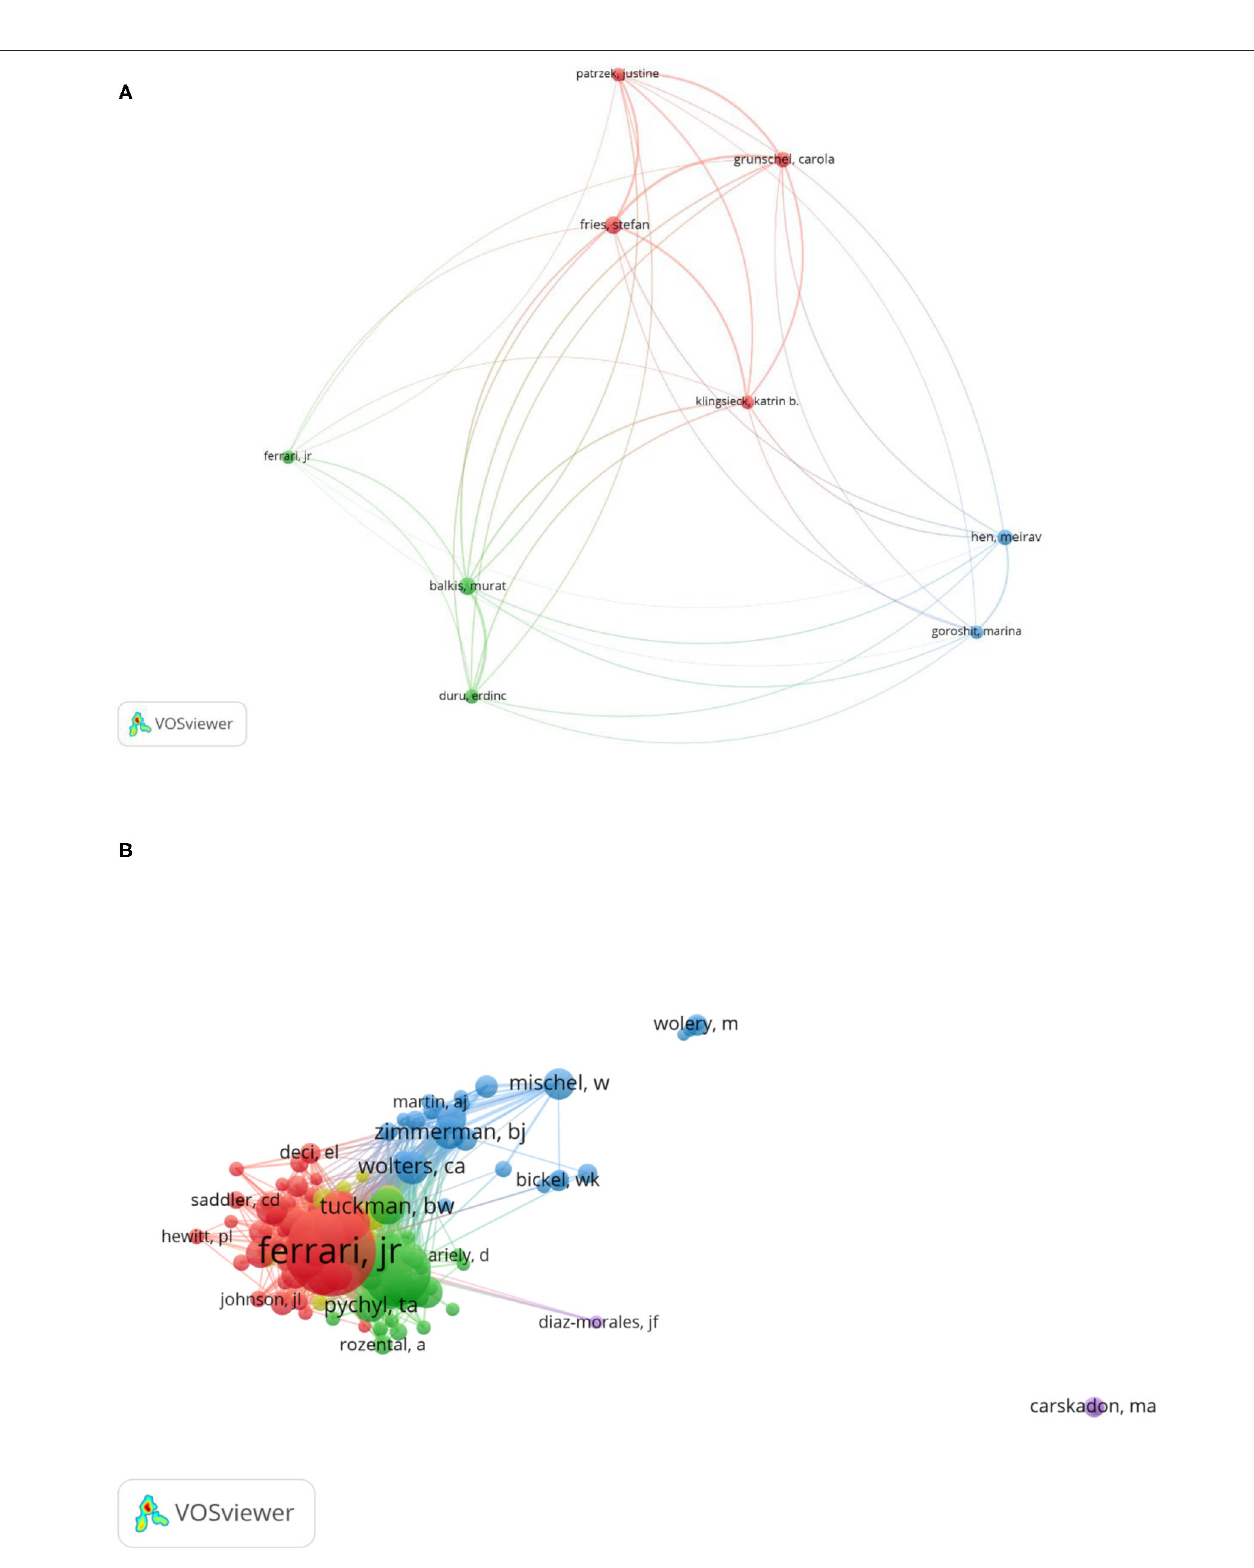
FIGURE 4 | The visualization map of main authors participating in academic procrastination research: (A) Mapping of main authors participating in academic procrastination research. (B) Mapping of co-cited authors participating in academic procrastination research.